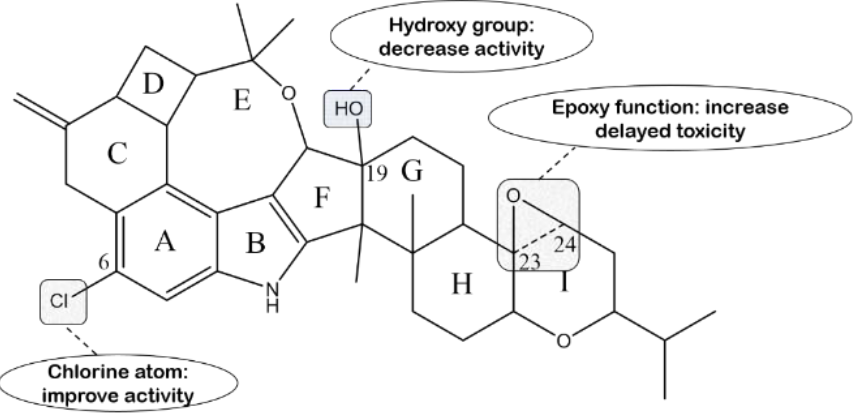
Figure 22. Structure – activity (anti-insect) relationship of penitrem indole diterpenes.